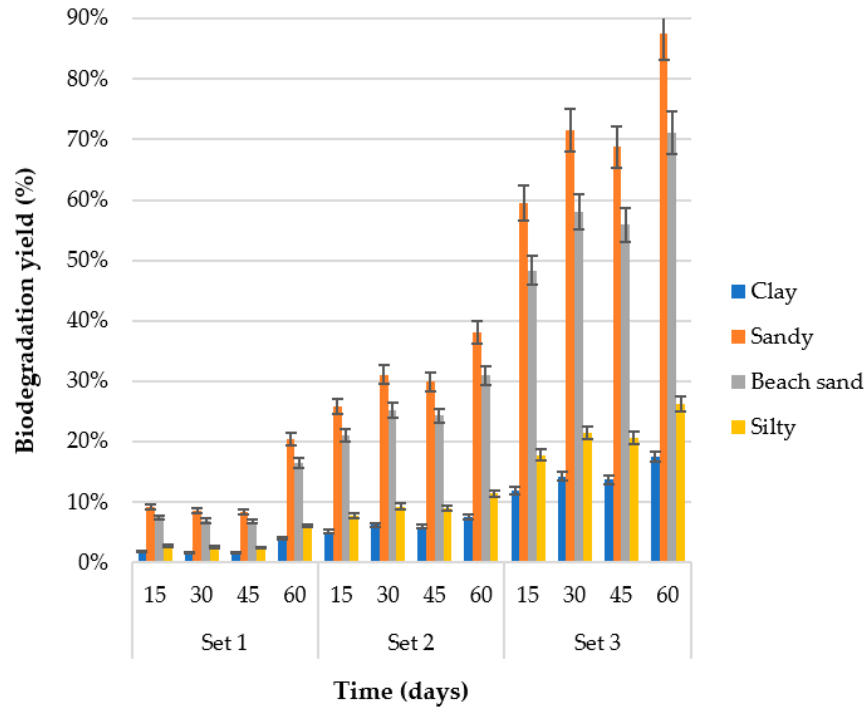
Figure 11. Yield of motor oil biodegradation. Set 1: contaminated soil + sugarcane molasses + S. bombicola ; Set 2: contaminated soil + sugarcane molasses + S. bombicola + biosurfactant at CMC; Set 3: contaminated soil + sugarcane molasses + S. bombicola + biosurfactant at twice the CMC. Error bars show the corresponding standard errors.